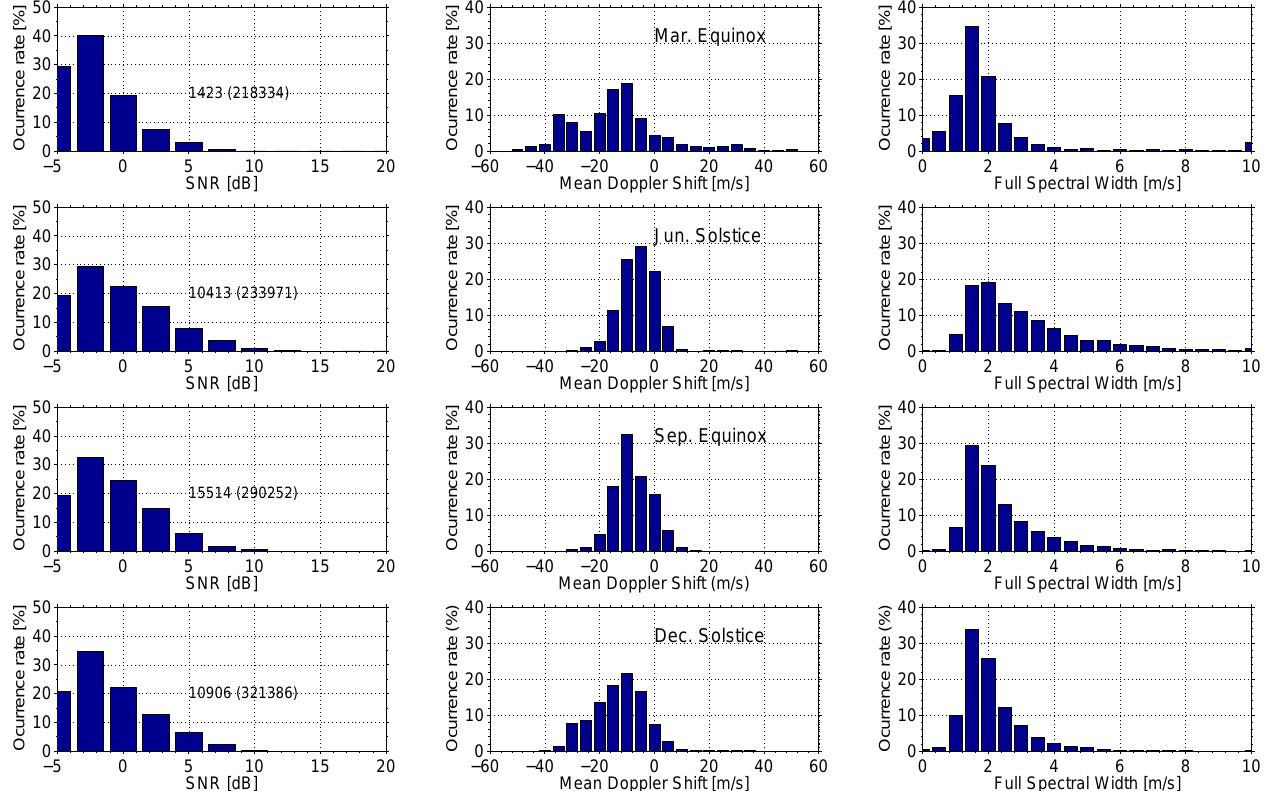
Fig. 7. Histograms of SNR (left side panels), mean Doppler shift (middle panels) and spectral width values (right side panels) of 150-km echoes observed by the S˜ao Lu´ıs radar in 2008 as a function of season